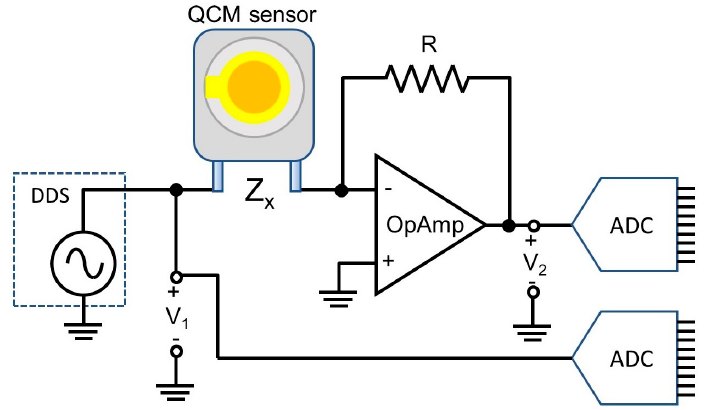
Figure 4. Auto-balancing impedance bridge scheme.